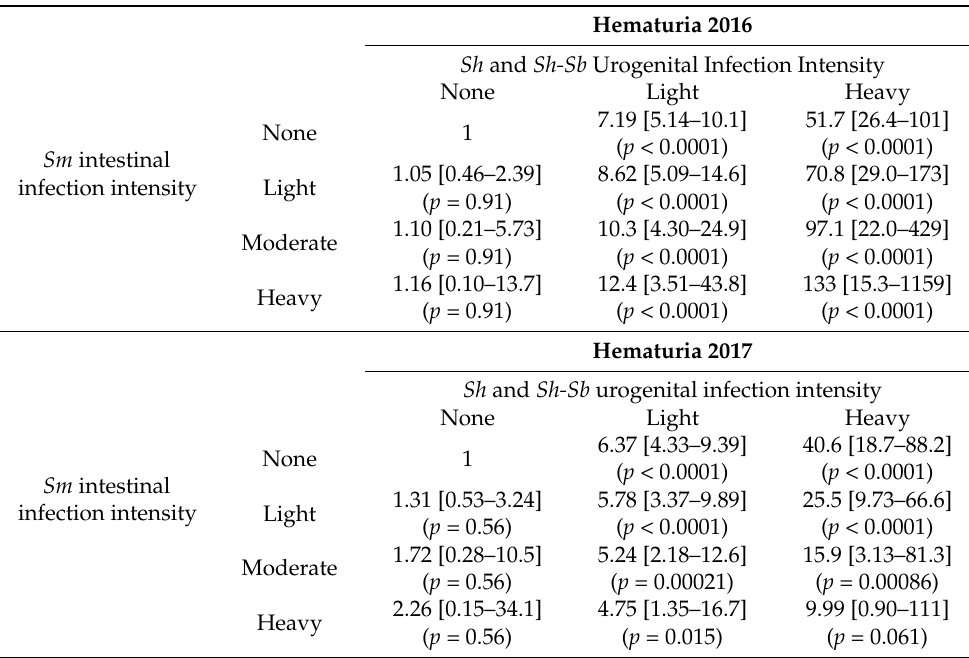
Table 2. Odds ratio [95% confidence interval] and p -values (in parentheses) of hematuria being in category j or above ( j = +, ++ or +++) among children in Senegal in 2016 and 2017, depending on schistosomiasis infection intensity and adjusted for age, sex, and study site. Only individuals with complete data on hematuria, urogenital or intestinal infection intensities, age, sex, and study site were included in the cumulative link logistic regression models ( n = 509 in 2016; n = 472 in 2017). Hematuria 2016 Sh and Sh-Sb Urogenital Infection Intensity